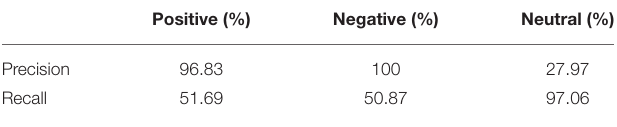
TABLE 2 | Using NLTK sentiment analysis on the verb members of a few VerbNet